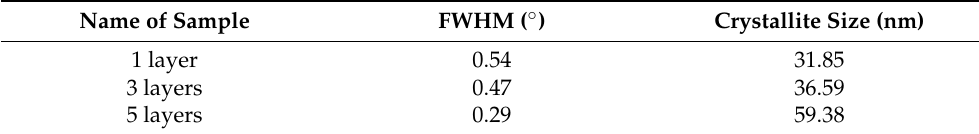
Table 2. Characteristic of ZnO seed layer of (101) plane estimated from XRD patterns.